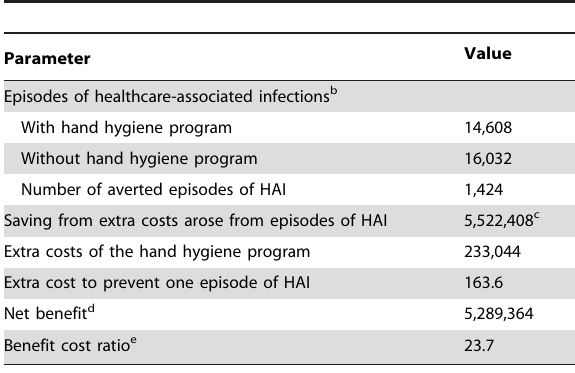
Figure 3. Time trends of monthly cumulative incidences by pathogen. (A) methicillin-resistant S. aureus (MRSA) (change in level, p =0.03; change in trend, p =0.04); (B) extensively drug-resistant Acinetobacter (XDRAB) ( p =0.78; p , 0.001, respectively); (C) Escherichia coli ( p =0.89; p =0.33, respectively). Infection control measures for XDRAB were intensified during June 2001 to June 2002. These efforts resulted in only a transient reduction in the rates of infection for XDRAB and MRSA. Observed incidences, black solid line, —; mean, red dash line, ---; green and blue shadow, 95% confidence interval of observed incidences; yellow shadow, 95% confidence interval (CI) of predicted incidences. The vertical dashed lines (- - -) separate the preintervention and intervention periods.